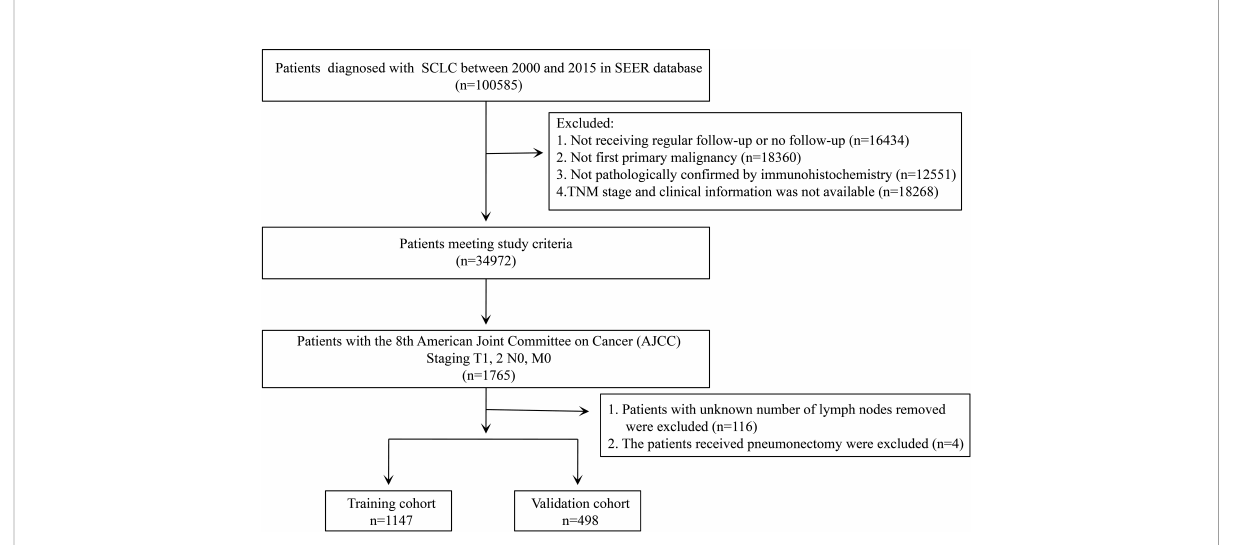
FIGURE 1 The fl ow chart shows the process of patient